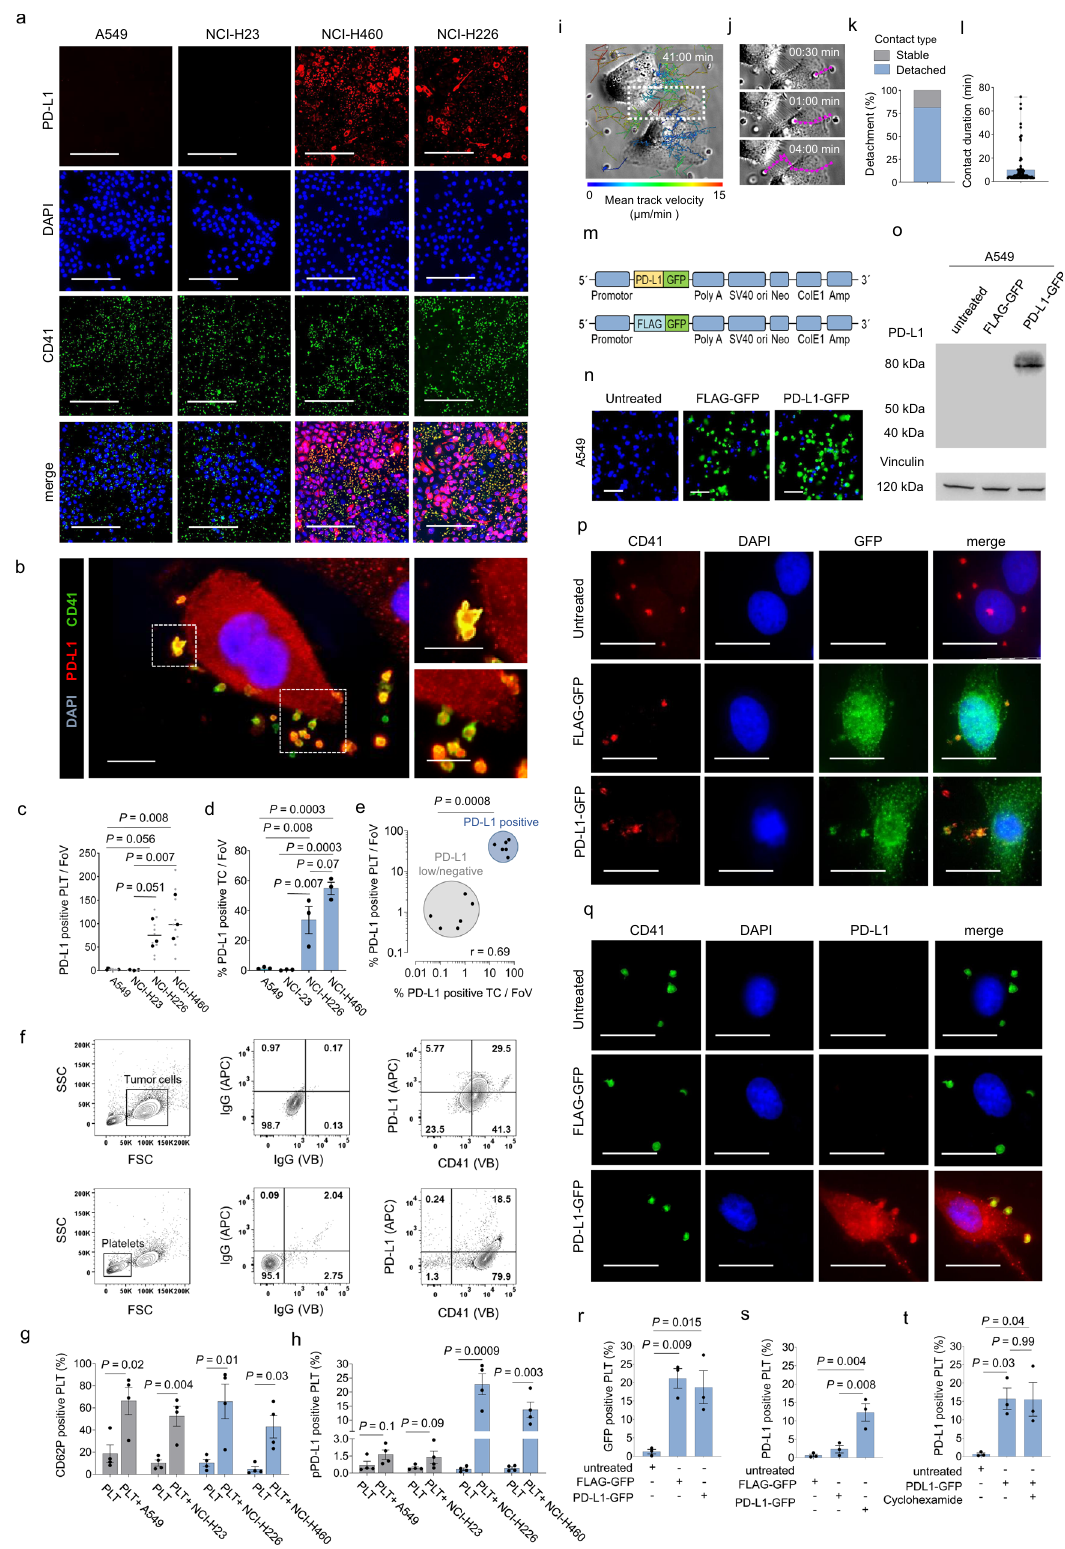
(Fig. 2r – t) and PD-L1 protein transfer (Fig. 2u, v), inhibition of GPIIbIIIa by Tiro fi ban only marginally reduced platelet adhesion (Fig. 2r –